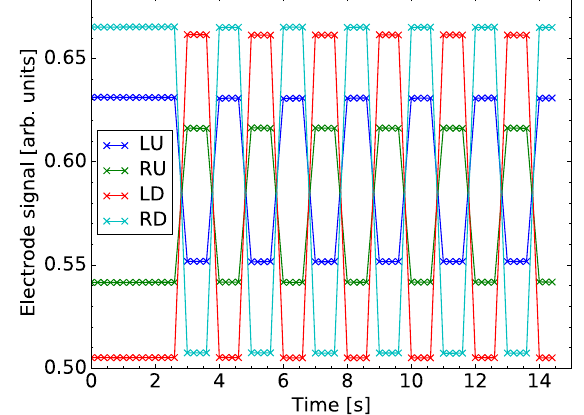
FIG. 3. BPM electrode signals during the electronics calibration test (LU ¼ left-upstream, LD ¼ left-downstream, RU ¼ right-upstream, RD ¼ right-downstream). The BPM sig- nals are flipped several times in order to obtain repeated mea- surements to counter for changes in the beam orbit and intensity which affect the electrode signals.